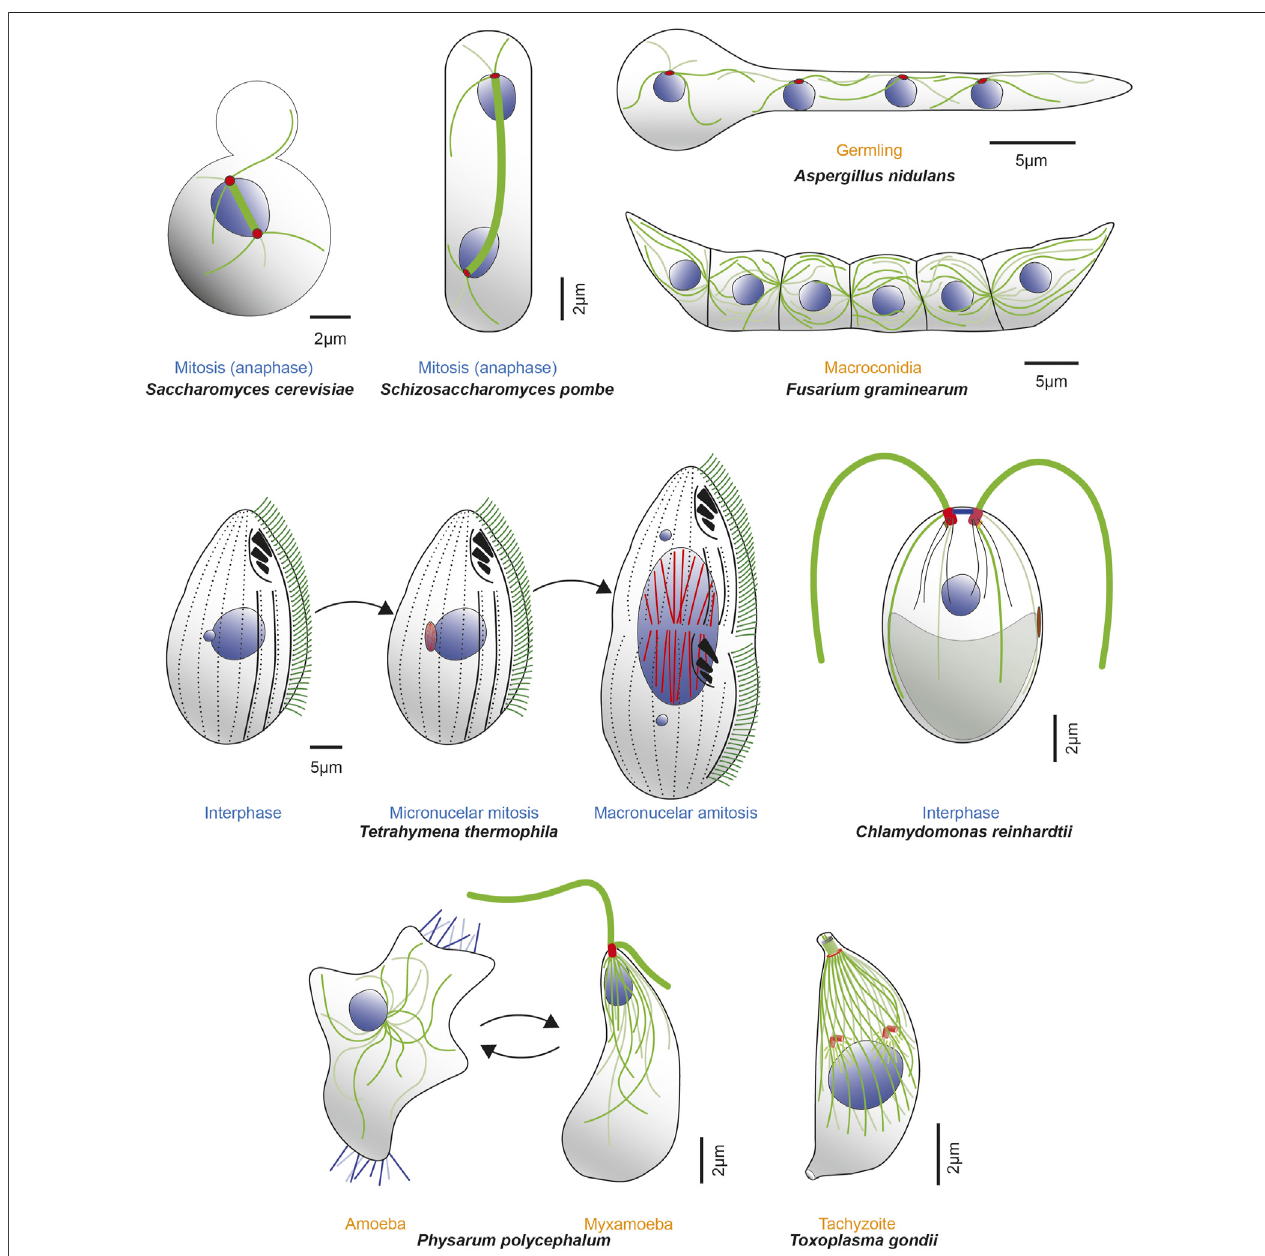
FIGURE 2 | Microorganisms express one or more α - and β -tubulin isotypes to construct various MT-organelles and to perform diverse functions with a range of complexity. Example microorganisms are represented in either different cell cycle (blue text) or life cycle (orange text) stages, along with MTs (dark and light green lines), mitotic spindle (thick green line), nuclei (blue) and corresponding MTOCs (red). Top row (from left to right, clockwise): schematics of mitotic S. cerevisiae in anaphase; mitotic S. pombe in anaphase; tetranucleate, interphase Aspergillus nidulans germling (germinated from conidia, an asexual, uninucleate spore produced during vegetative life cycle. Septa are not formed until third karyokinesis) and infectious F. graminearum multicellular macroconidia, the translucent, canoe-shaped asexual spores possessing 4 – 5 septa and derived from phialides, the conidium producing cells. Middle row (left): T. thermophilus undergoing cell division and demonstrating distinctlocalizationof β -tubulinisotypes.Btu2isenrichedinsomaticcilia(greenlinesoncellsurface)andbasalbodies(blackdotsbeneatheachciliumoncellsurface;not all cilia are shown). Blt1 and Blt4 construct the spindle (red lines) in the mitotic division of the micronucleus (smaller blue circle) and also assemble MTs (red lines) during amitotic division ofthe macronucleus (large blue circle). Middle row (right): C. reinhardtii in interphase, showcasing diverse MT organelles including the twoapical fl agella (thick green lines projecting outward)and 4 MTrootlets (thinner green and lightgreen lines emergingfrom basalbodies within thecell), which contains stable,acetylated α -tubulin.Themother(red)anddaughter(darkred)basalbodies,severalnucleus-basalbodyconnectors(blacklines),eyespot(brown)andchloroplast(greyobjectatcell posterior)arealso shown.Bottom row (left): P.polycephalum depicted inrespectiveamoebaand fl agellatestages. Theuninucleateamoeba (left)haveunorganized MTs (greenlines),randomlypositionednucleus(bluecircle)with fi lopods(bluelinesextendingfromthecytoplasm)thatcontributestomultidirectionalmovements. Itreversibly transitions to the uninucleate, comma-shaped, fl agellated, sexual spore myxamoeba (right). This phase demonstrates an anterior and posterior fl agellum (thick green ( Continued )